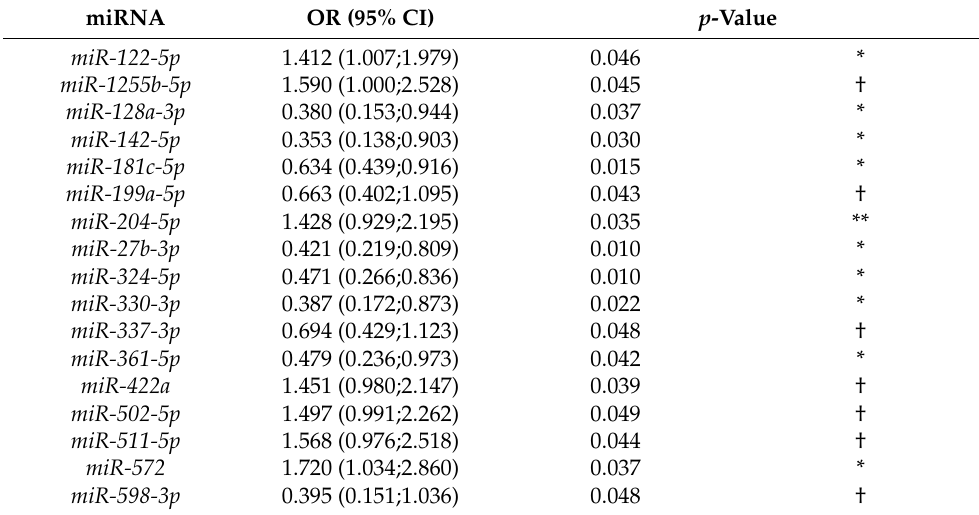
Table 2. List of 17 hemolysis-free candidate miRNAs from univariate analysis on training